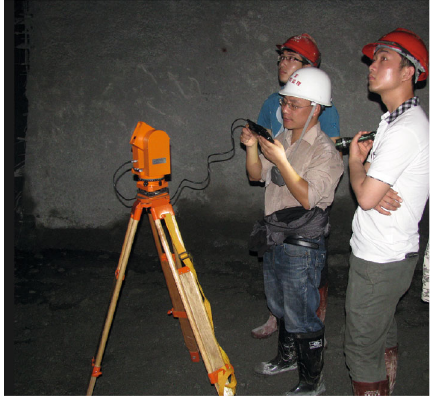
Figure 8: Tunnel pro fi